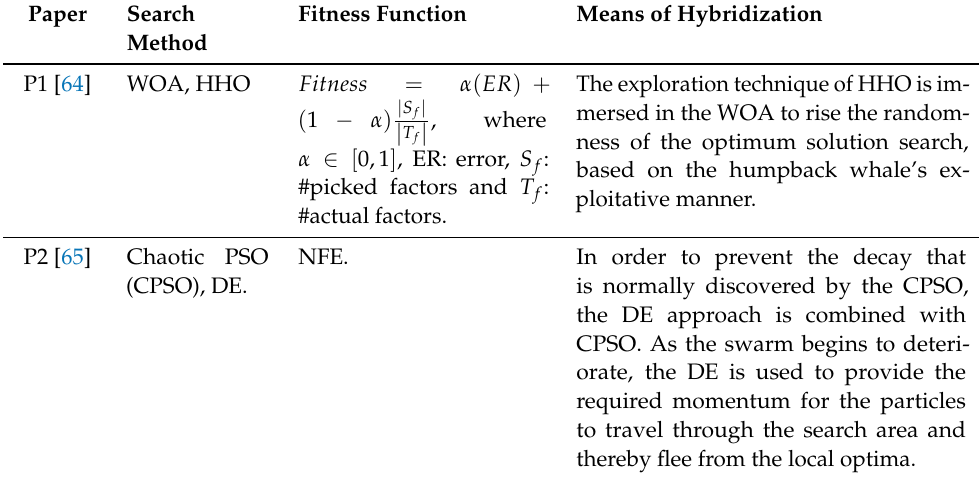
Table 3. Search methods, their fitness function details, and means of